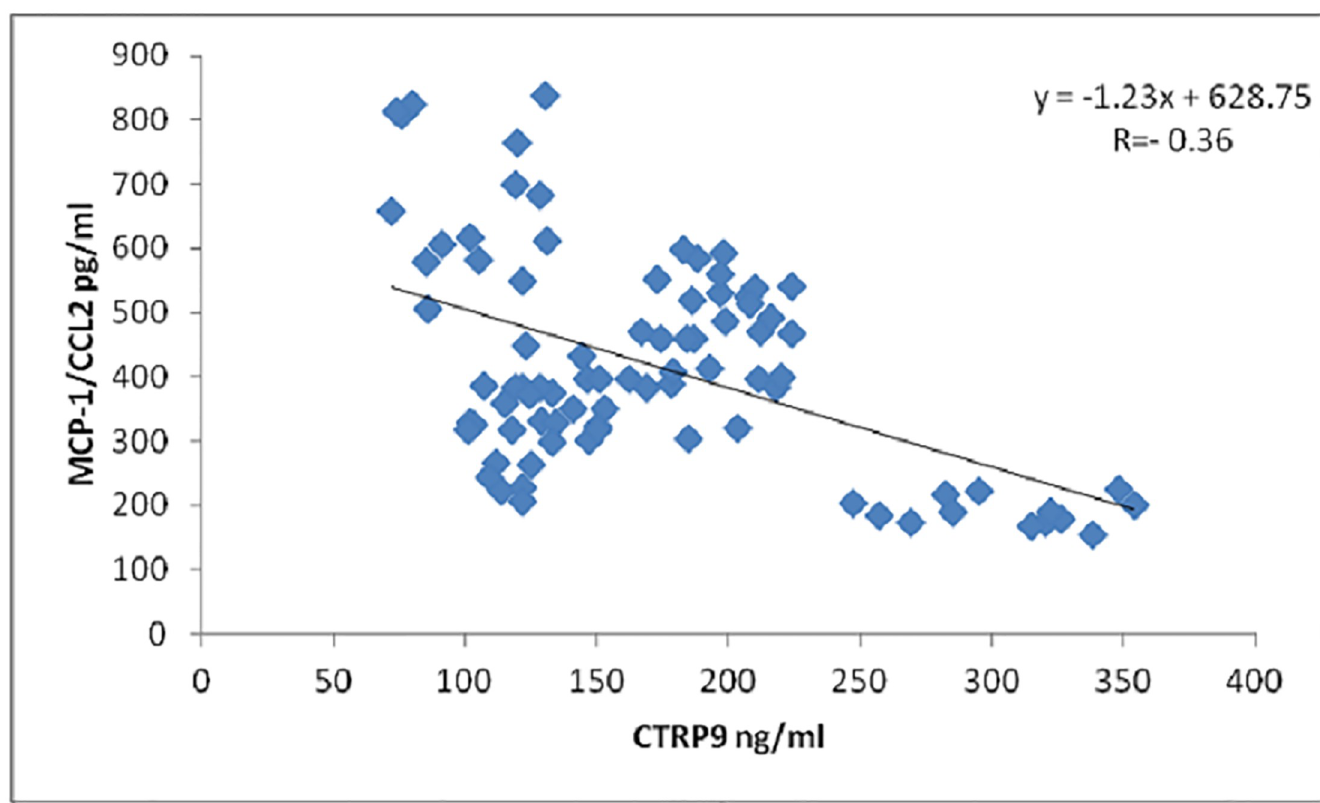
Fig 5. Correlation between MCP-1/ CCL2 and CTRP9. CTRP9: C1q complement/tumor necrosis factor (TNF)—related protein 9, MCP-1/ CCL2: Monocyte chemoattractant protein-1.